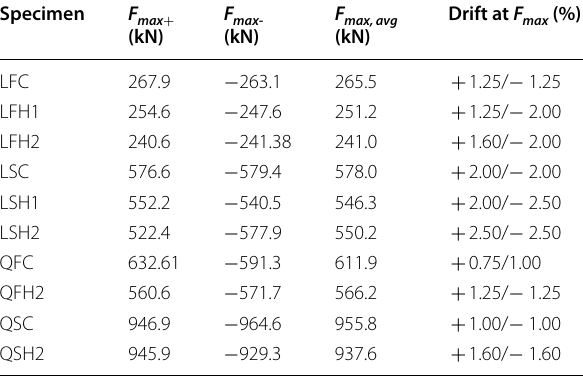
Table 4 Cyclic loading test results of the specimens.